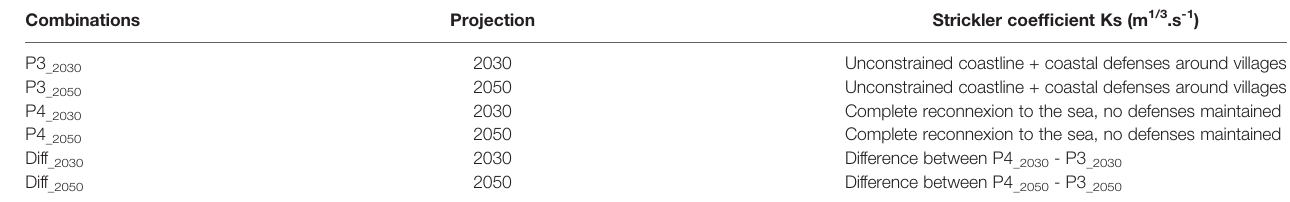
TABLE 4 | Summary of coastal management scenarios presented.